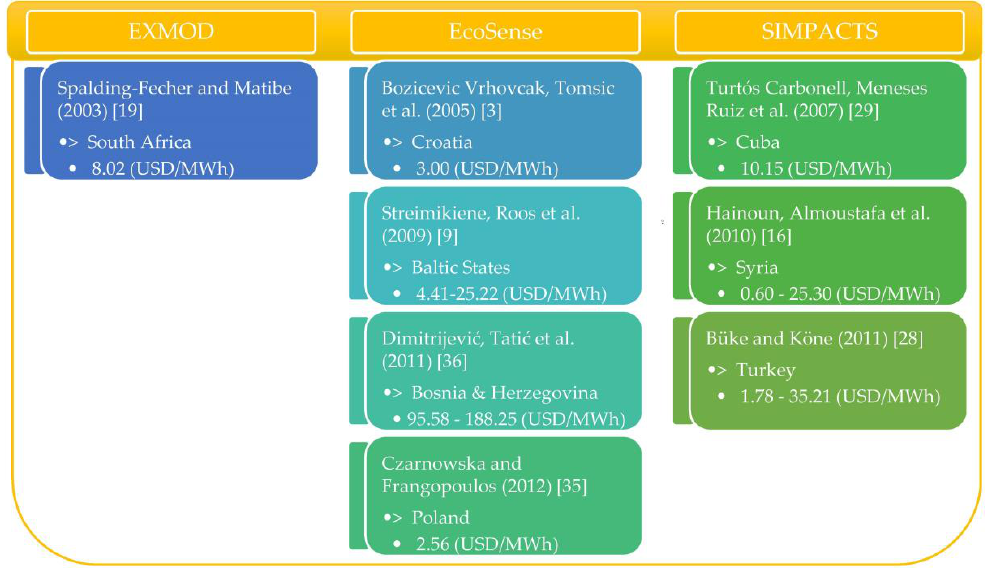
Figure 2. Summary of electricity externality studies by different models applied in different countries.